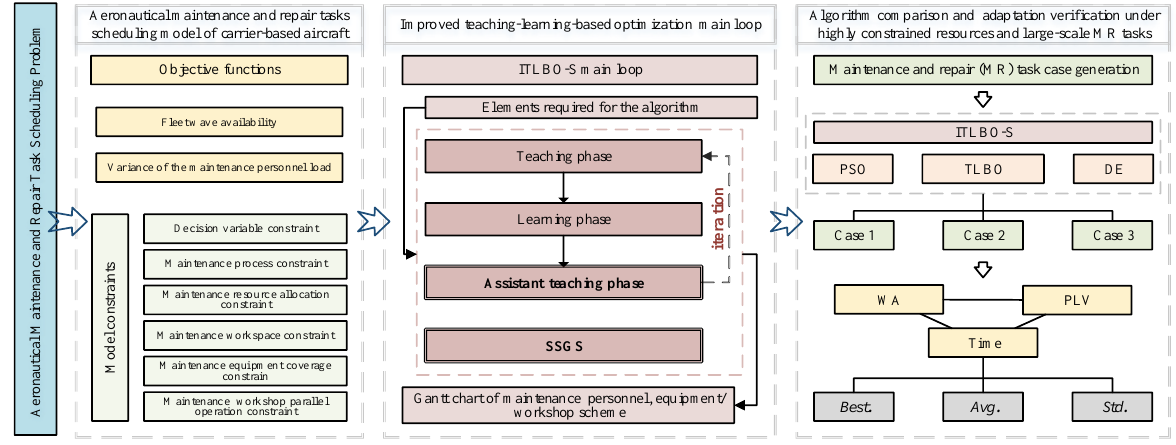
Figure 1. Research content and framework.